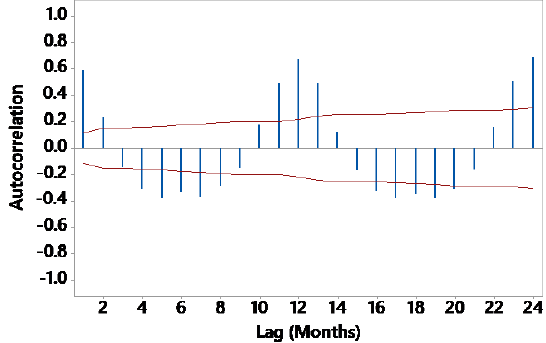
Fig. 5. Correllogram for the IB series. AR(1) correlation coefficient is 0.6. Confidence intervals (95%) are in